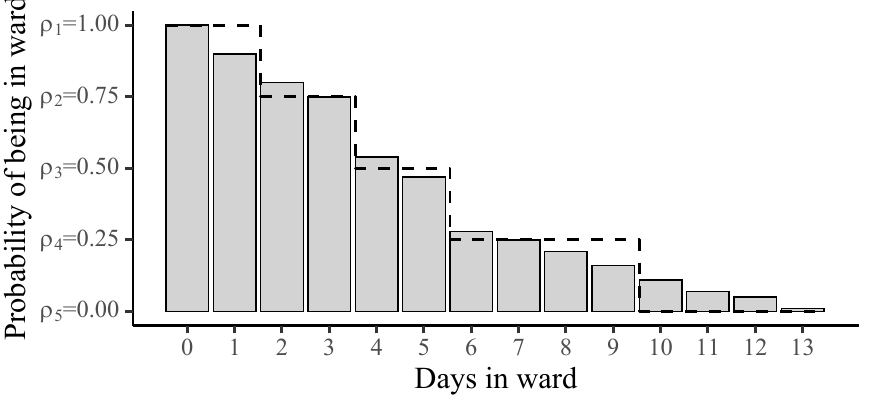
Figure 1. Approximating the expected length of stay (LOS) in ward with equal probability intervals of length |K| . Here, |K| =